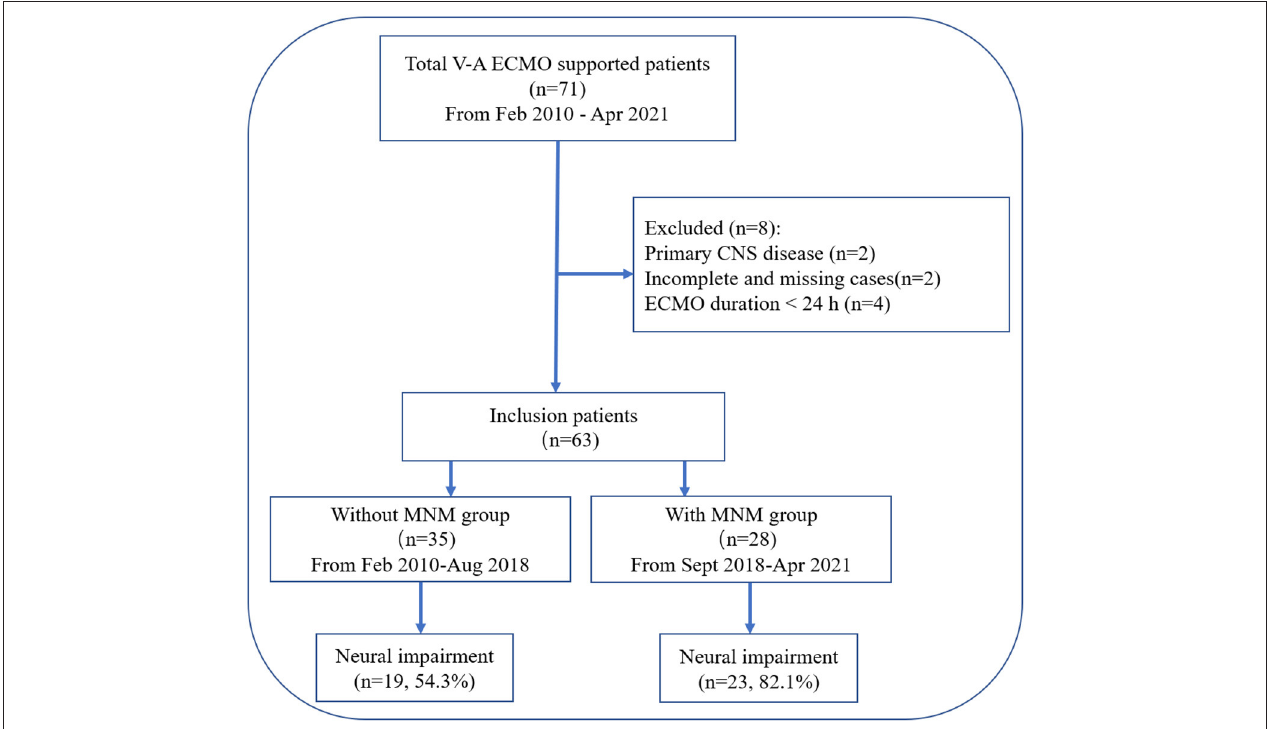
FIGURE 1 | Flow chart of the patient cohort. VA-ECMO, venoarterial extracorporeal membrane oxygenation; CNS, central nervous system; MNM, multimodal neurological monitoring.